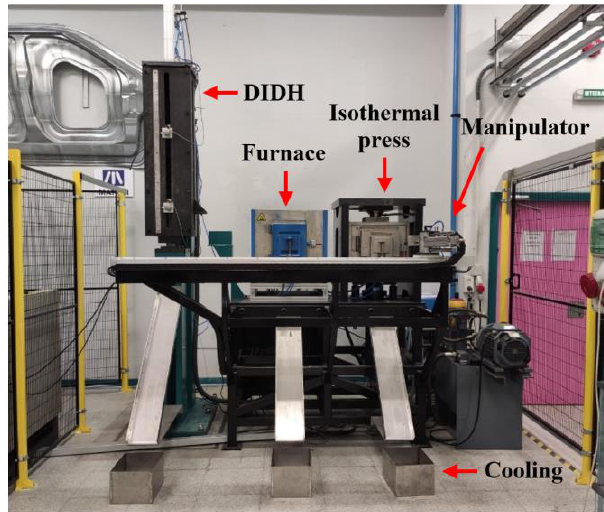
Figure 1. The Automatic ThermoMechanical Tester